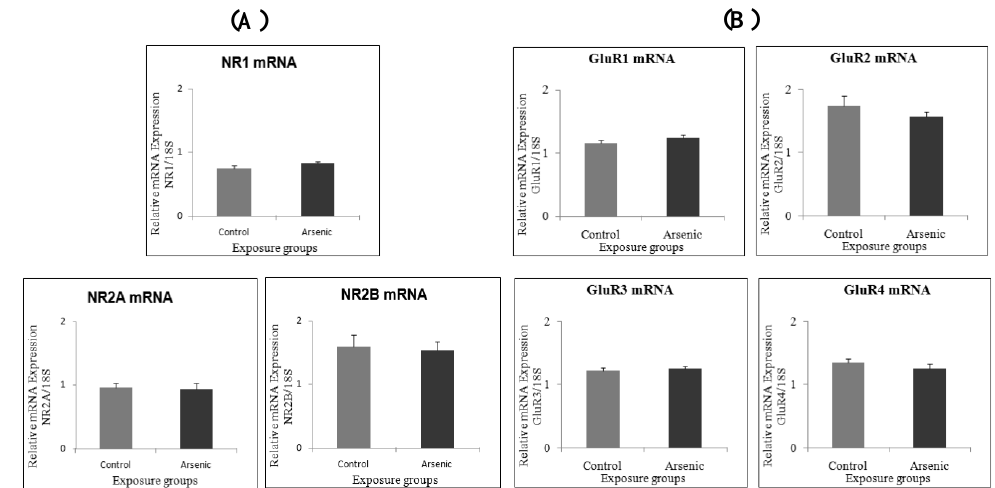
Figure 2. Messenger RNA expression level of ( A ) NMDA receptor subunits, and ( B ) AMPA receptor subunits in the prefrontal cortex of the control group and the arsenic-exposed group of 74-week-old male mice. Each bar represents the mean ± SE ( n = 14).